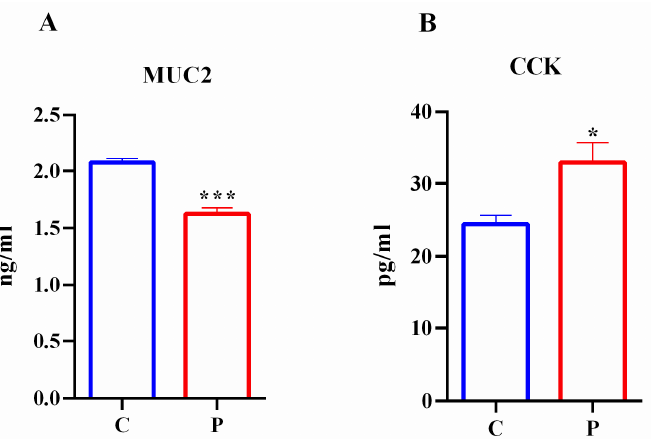
Figure 10. Effects of palmitate exposure on MUC2 and CCK production in intestinal organoids. MUC2 ( A ) and CCK ( B ) secretion from intestinal organoids treated with palmitate. ( n = 3). Data are expressed as means ± SD. Unpaired Student’s t test: * p < 0.05, *** p < 0.001. C, control; P, palmitate.